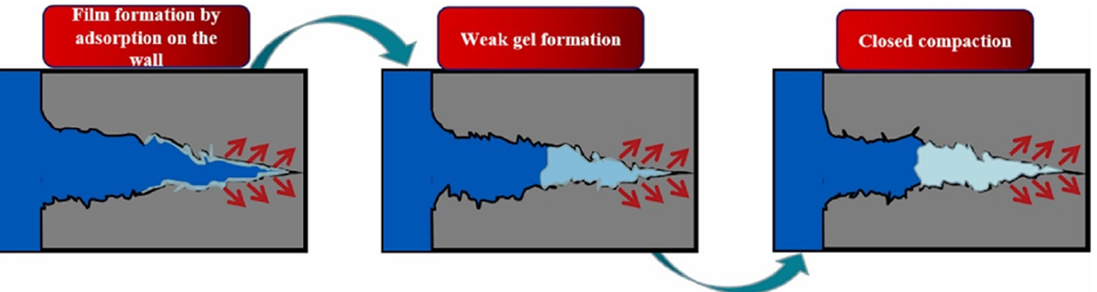
Figure 16. Plugging mechanism of in situ crosslinked gel slug in fractures. (Reprinted/adapted with permission from Ref. [42], 2022, Zhou et al.).